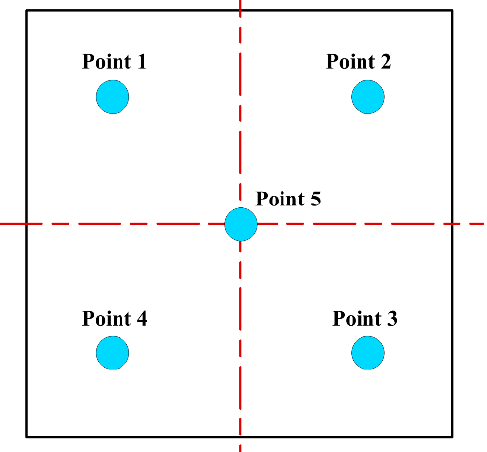
Figure 8. Schematic showing the five observing points on the KDP crystal. For the water-dissolution polishing method, the material is removed by water dissolution with micro water droplets in the polishing fluid, and a super smooth surface without scratches was obtained by polishing with a polishing fluid containing 7.5 wt.% water (as shown in Table 3). Under the condition of sufficient supply of polishing fluid, the surface quality of the polished KDP with polishing fluid containing 5 wt.% water crystal was not further improved. Moreover, microscopic scratches appeared locally on the crystal surface that caused damage to the polished surface. Table 3. KDP surface after polishing with different water contents of polishing fluid. 5 wt.%